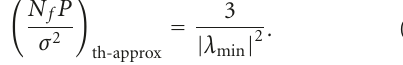
Figure 7: BER performance of MC-CDMA with MMSE equalizer, evaluated using (21) (Plots 1 and 2 are without regularization, plots 1 (cid:7) and 2 (cid:7) are with regularization based on the threshold SNR estimated from plot 1 as described in Section 5.3, plots 1 (cid:7)(cid:7) and 2 (cid:7)(cid:7) are with regularization based on the threshold SNR computed from (26), Plots (1,1 (cid:7) ,1 (cid:7)(cid:7) ) and (2,2 (cid:7) ,2 (cid:7)(cid:7) ) correspond to RFOs = 0.05 and 0.03, respectively, N f = 64 and channel realization is CR-1 given in Table 1, and symbols are from 4-QAM constellation with P =